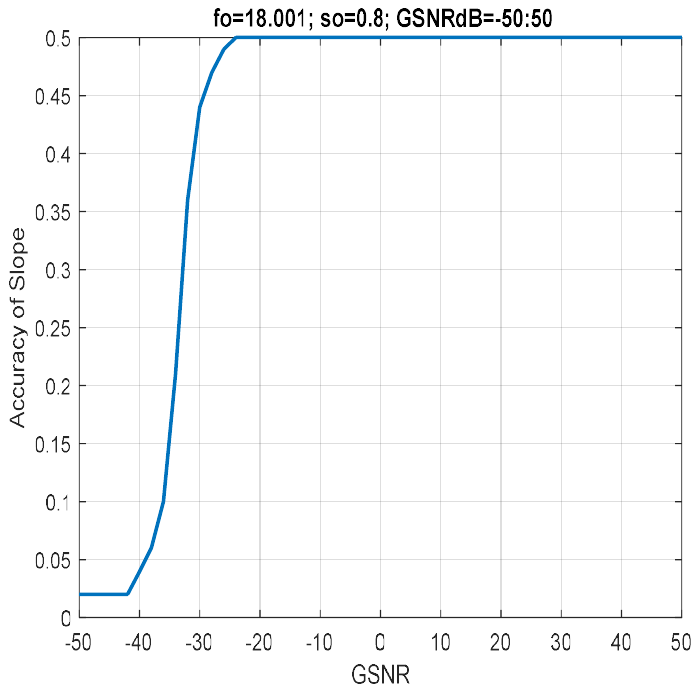
Figure 23. Accuracy of SE for noisy LFM by CNN, where f o = 18.001.